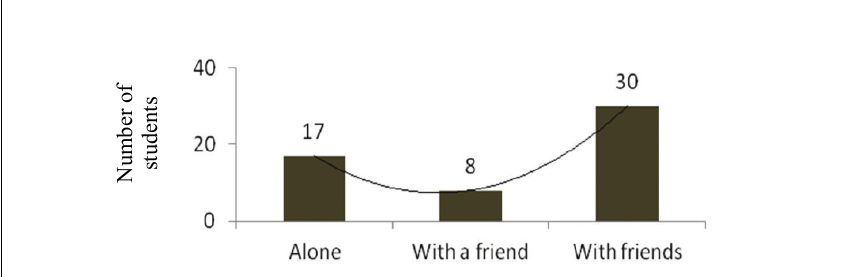
Figure 4. Ways of doing sport